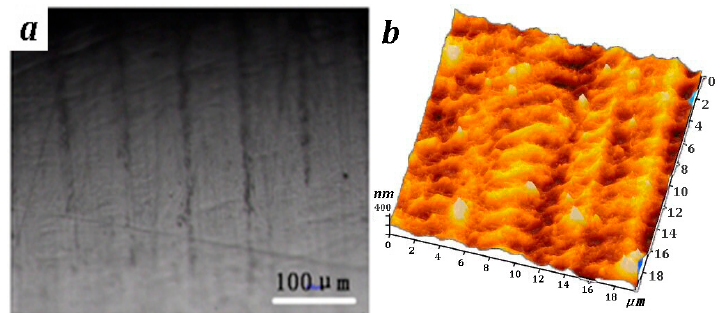
Figure 4. Surface feature of UNSM: ( a ) Optical micrograph; ( b ) 3-D microscope image by atomic force microscope (AFM).